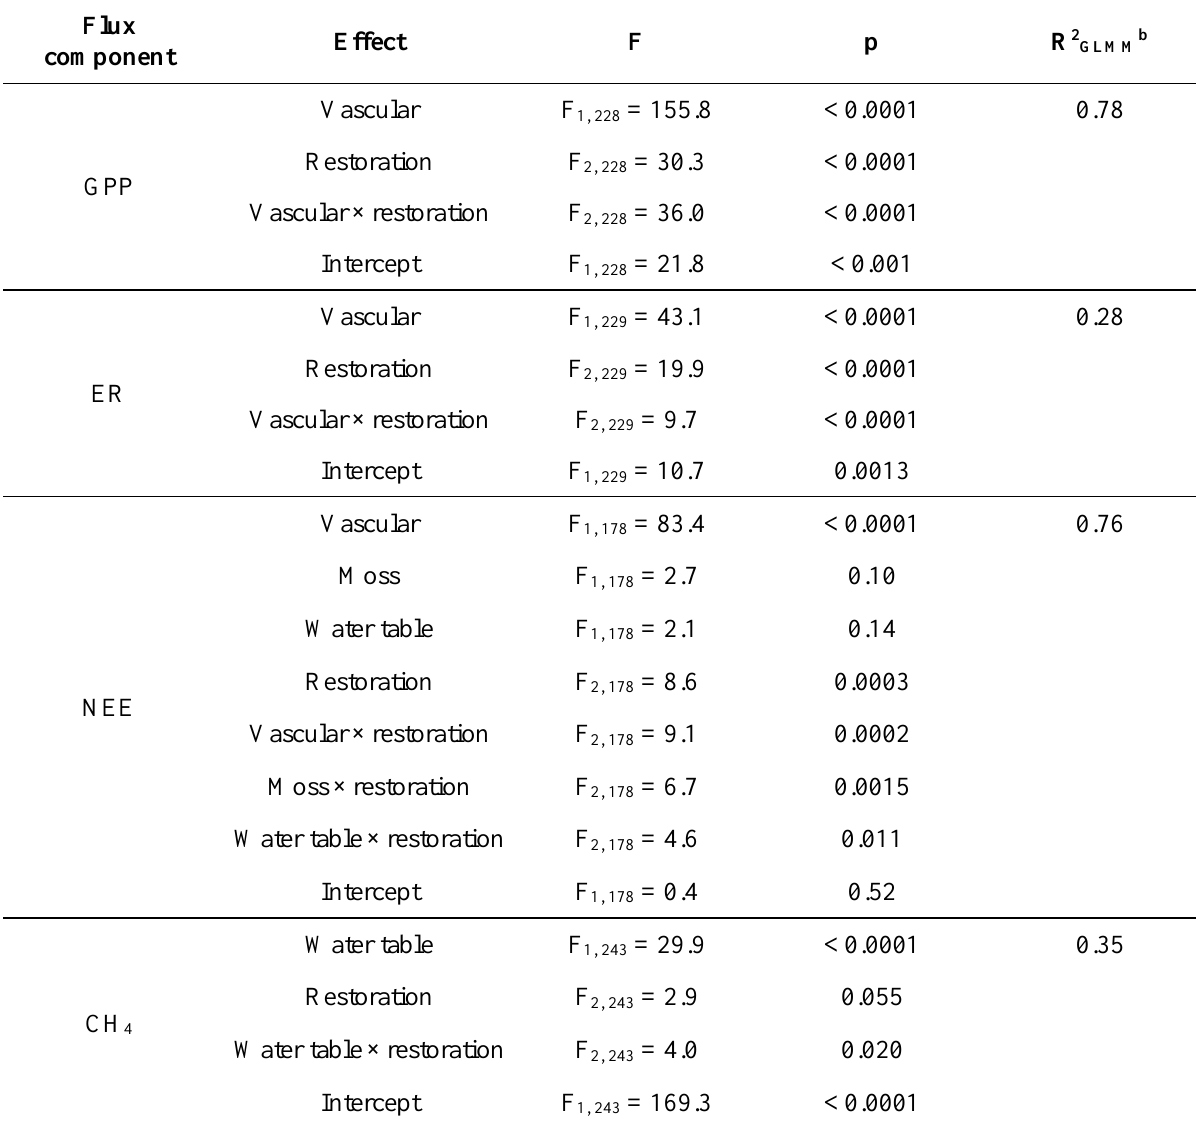
Table 2. Statistical results of linear mixed effects models a